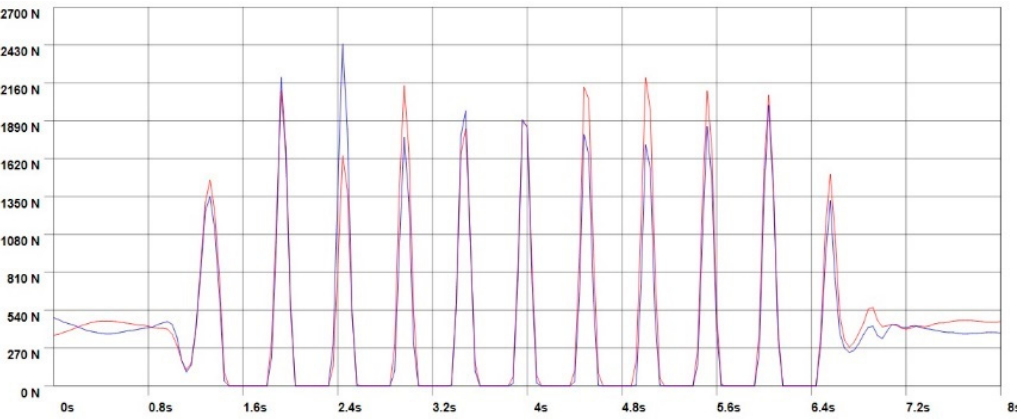
Figure 4. An example of 10 consecutive double-leg vertical hops vGRF values obtained in the right ( blue line ) and left ( red line ) legs, with the highest vGRF values representing the peak landing values. The first double-leg landing was registered at 2.0 s.